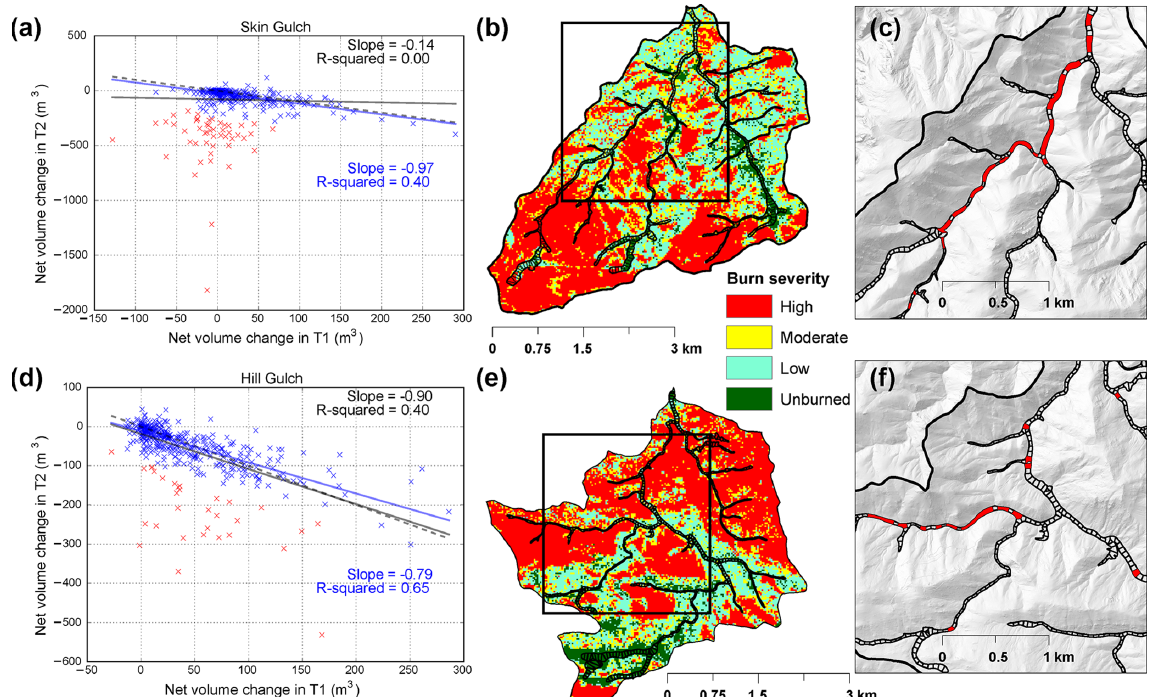
Figure 11. Regression of the net volume change for each 50m segment for T2 (the period including the large erosional mesoscale flood of 201307–201310) against the net volume change for T1 (the depositional period of 201210–201307) for (a) Skin Gulch and (d) Hill Gulch. The red x’s in (a) and (d) are the segments with much more erosion in T2 than deposition in T1, causing them to deviate substantially from the dashed − 1 : 1 line. The regression line and statistics for all of the data are shown in black, while the regression line and statistics in blue are for the truncated data after removing the red data points. (b) and (e) are burn severity maps of Skin Gulch and Hill Gulch, respectively, and the black boxes show the valley bottom segments in (c) and (f) . The red segments in (c) and (f) are the red data points in (a) and (d)